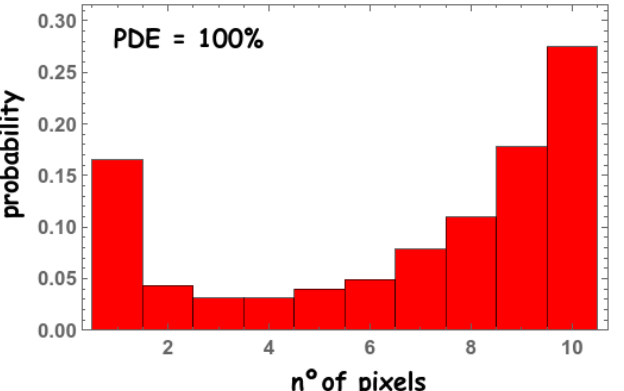
Figure 10. Simulated probability of detecting the first 10 fast photons in up to 10 different pixels for 1 × 1 mm 2 pixels for a PDE =